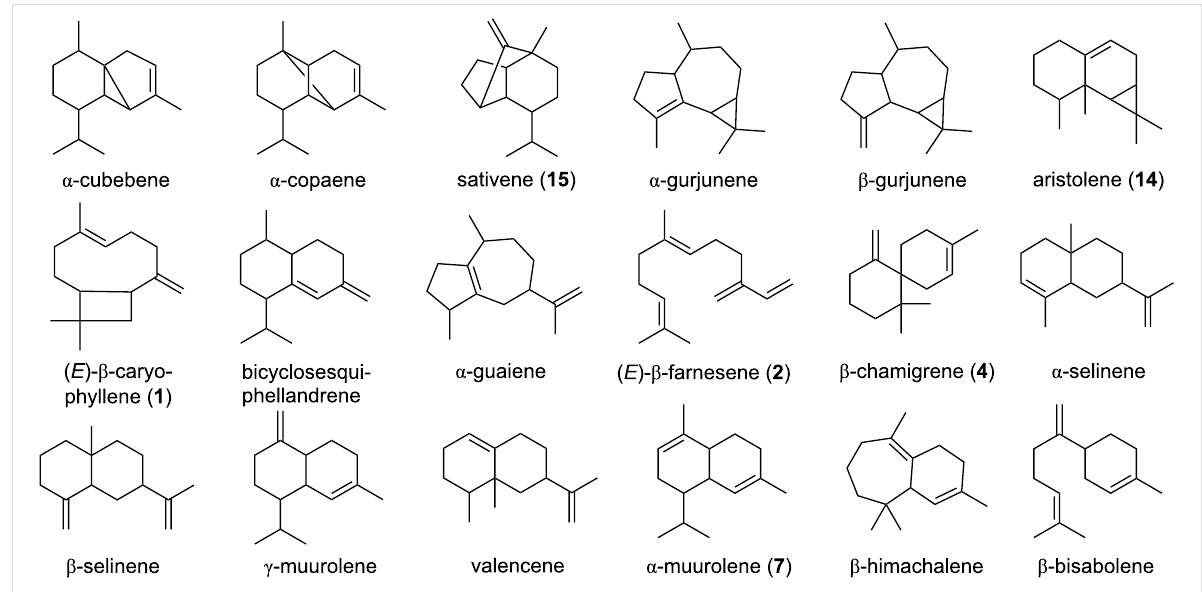
CxTPS2, while CxTPS1 converted this substrate to ( E,E )- β - springene ( 13 ) as the minor compound and major amounts of ( E,E,E )- α -springene ( 14 ) (Figure